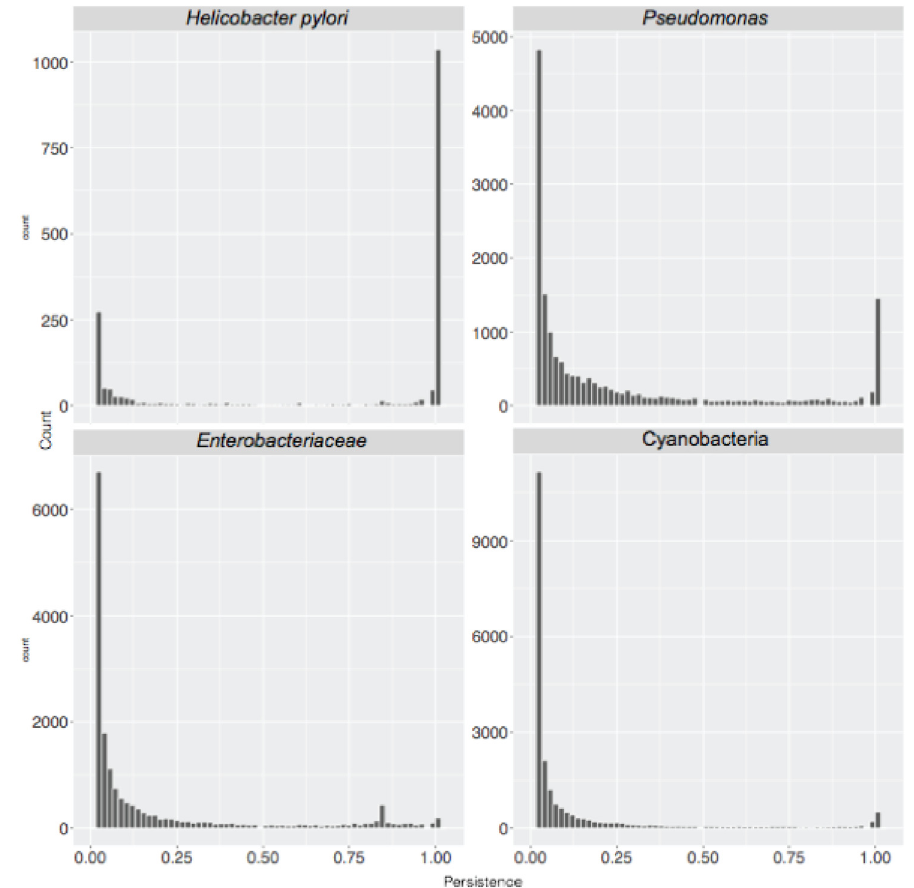
Figure S1. Persistence of Sequence Based (SB) clusters. Cluster persistence is defined as the relative number of genomes with at least one protein assigned to the cluster. The plots show frequency of SB clusters according to their persistence. Publicly available and complete genome sequences assigned to each taxon were selected so that phylogenetic diversity within the taxon was preserved, as described in materials and methods. 60 distinct genome sequences were considered for each taxon